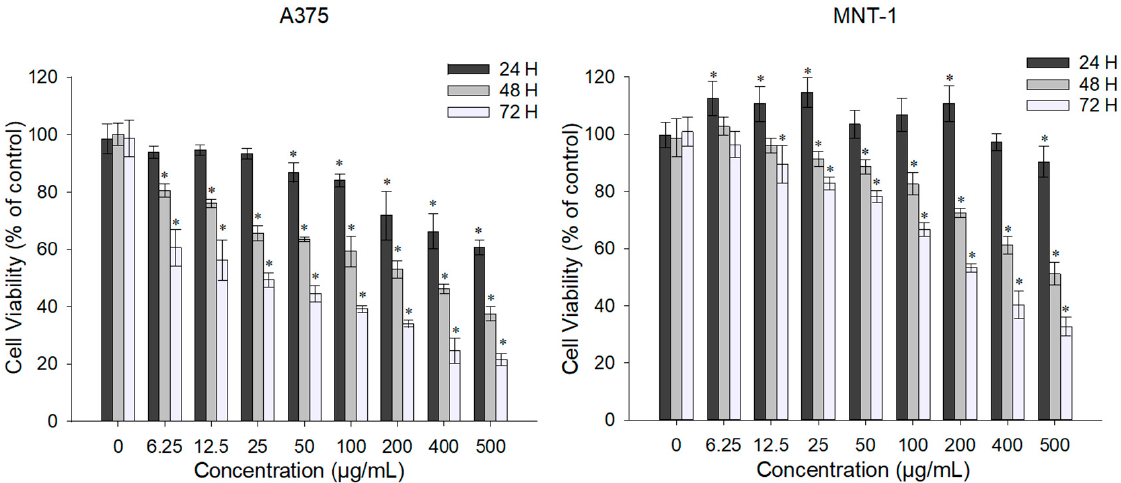
Figure 2. Effect of DTIC on the viability of A375 and MNT-1 cells. Cells were exposed to different concentrations of DTIC for 24, 48, and 72 h and cell viability was determined using MTT assay. Data shown are the mean values ± standard deviation of two independent experiments with four technical replicates each. * indicates statistical significance in comparison to the respective control ( p < 0.05).